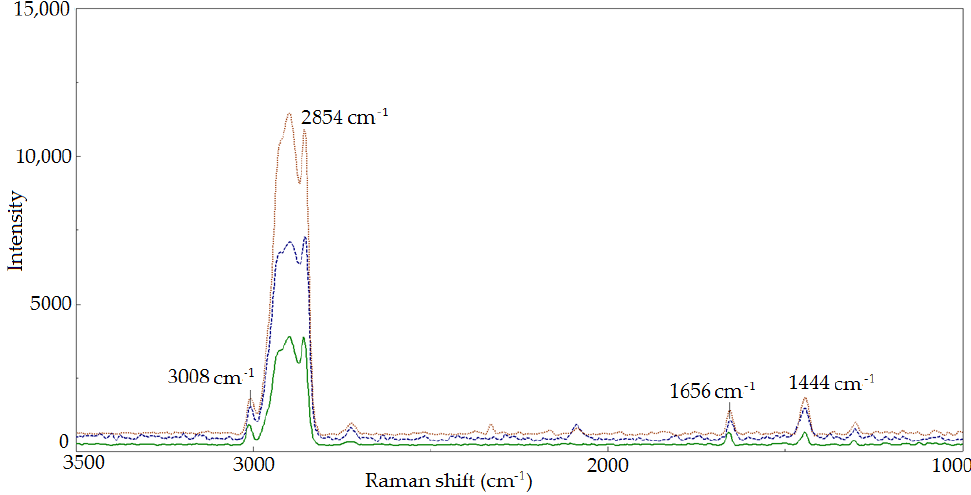
Figure 1. Raman spectra of A oil (green line) and A_CO 2 (blue line) as well as A_O 2 (red line) modified oils, in the 3500 cm − 1 –1000 cm − 1 range. Table 3. Chemical shifts and vibrational modes present in the Raman spectra of oils.